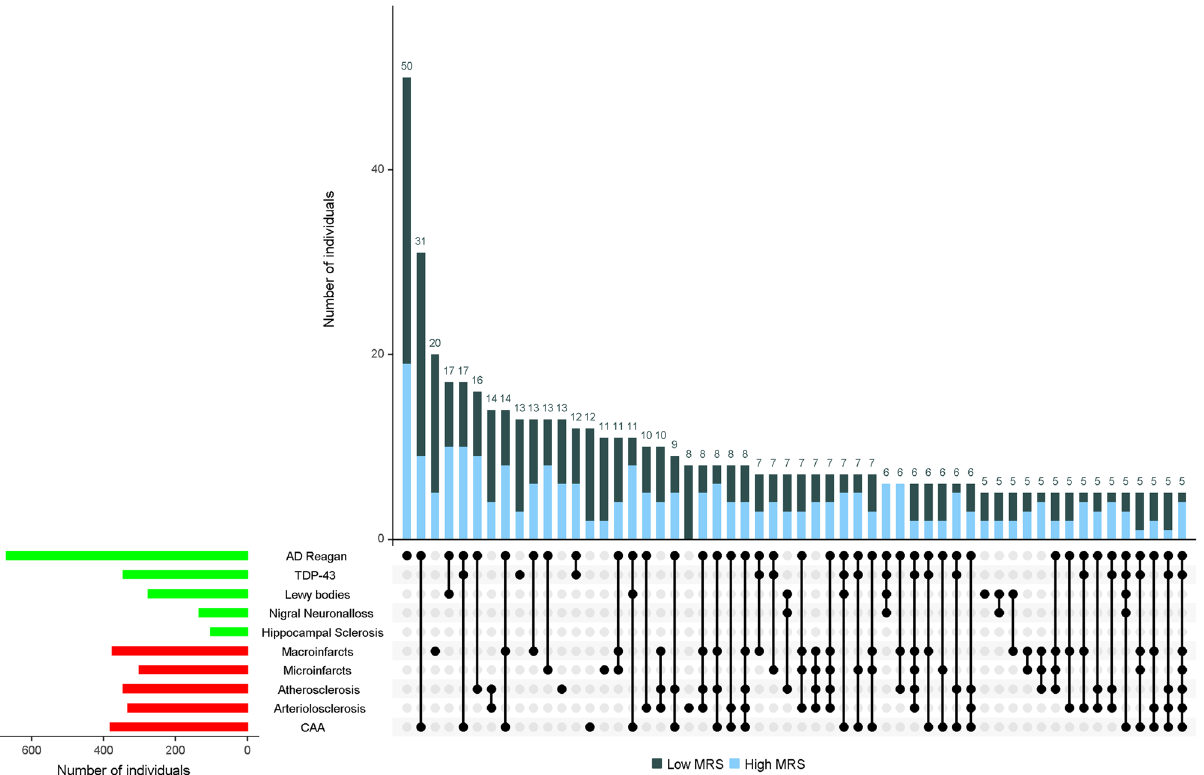
Figure 3. Motor resilience proteins mitigate the effects of heterogenous combinations of Alzheimer’s disease and other brain pathologies in older brains. The bar chart in the lower left corner shows the frequencies of ten individual brain pathologies indices collected in this study. One or more pathologies were observed in almost 95% of decedents. Connected black dots on the x-axis indicate the specific combination of brain pathology in 5 or more individuals. The second bar chart in the main panel show the frequencies of the brain pathology indices for persons with low or high motor resilience protein stratified by the median value for motor resilience protein [high motor resilience protein (blue) versus low motor resilience protein (black)], ordered by their frequency. The height of each bar corresponds to the number of persons with each combination. AD Alzheimer’s disease pathology; CAA cerebral amyloid angiopathy. As illustrated in the figure, brain pathology indices frequently co-occur. More than 80% of older adults in these analyses showed combinations of two or more brain